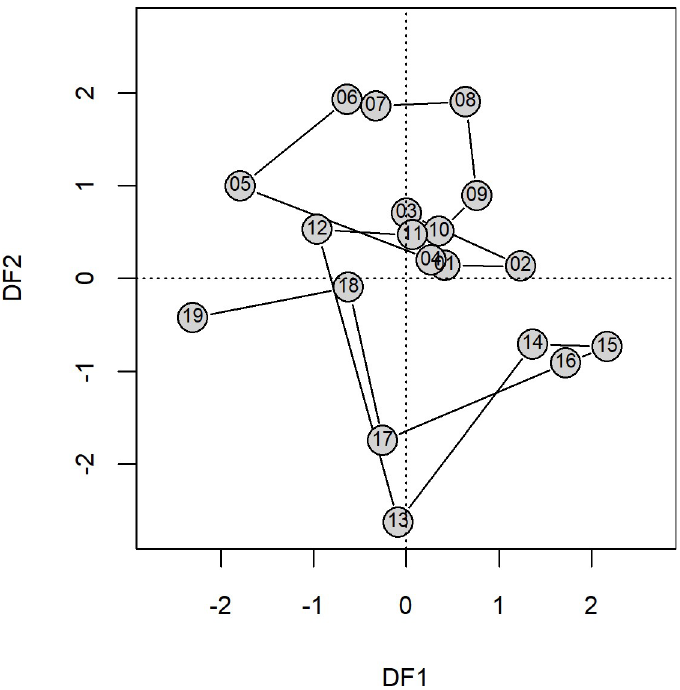
Fig 6. Biplot of Dynamic Factors (DFs) 1 and 2. Numbers within the points are the tens digit of year for 2001–2019 time series.